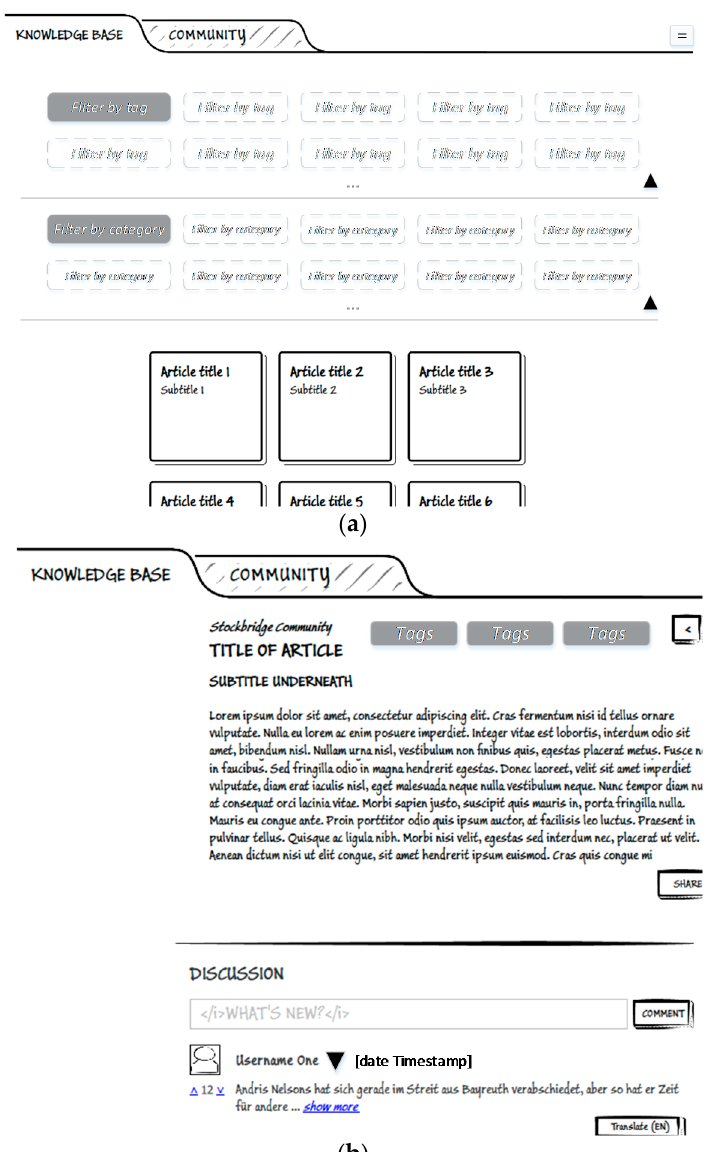
Figure 2. User platform–Knowledge base (registered user view) ( a ) Upper level (article tiles); ( b ) lower level (article